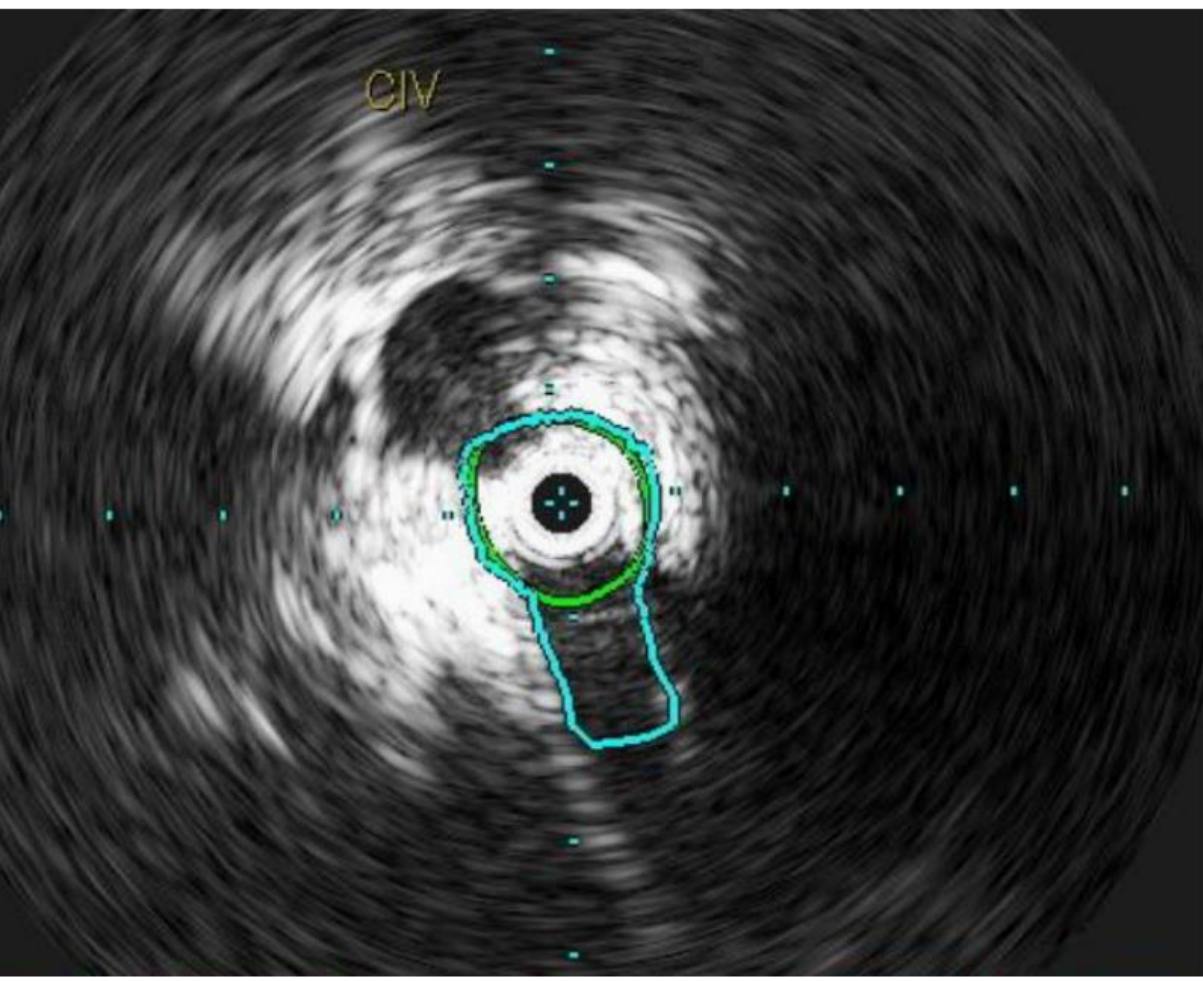
Figure 4. L common iliac vein is compressed between the vertebral body and the artery and appears as a narrow slit like structure. as a narrow slit like